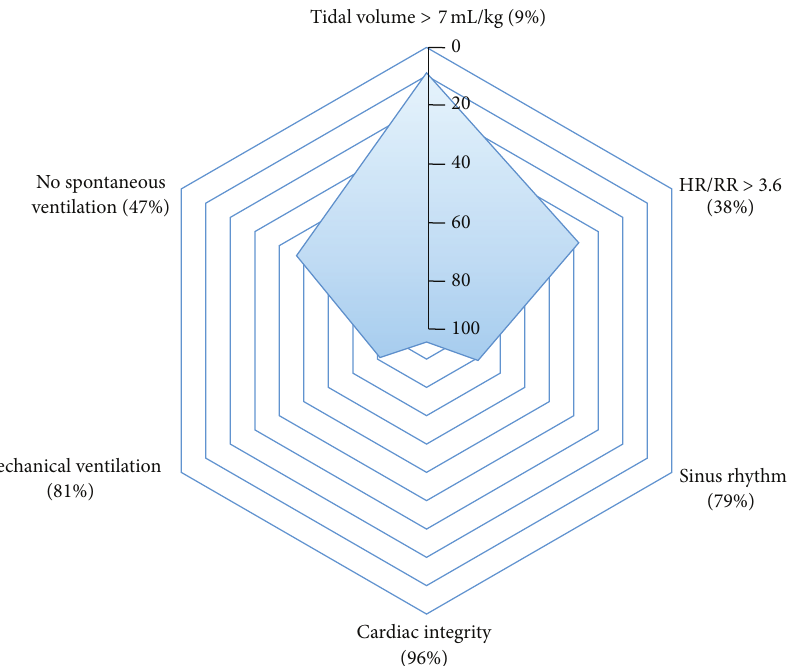
Figure 2: Radar chart showing the PPV applicability criteria according to the total number of UHE. The represented inverse scale allows one to observe the minimal presence of a tidal volume > 7 mL/kg IBW, especially in relation to other PPV contraindications. For instance, this chart shows that, in 81% of UHE, patients were mechanically